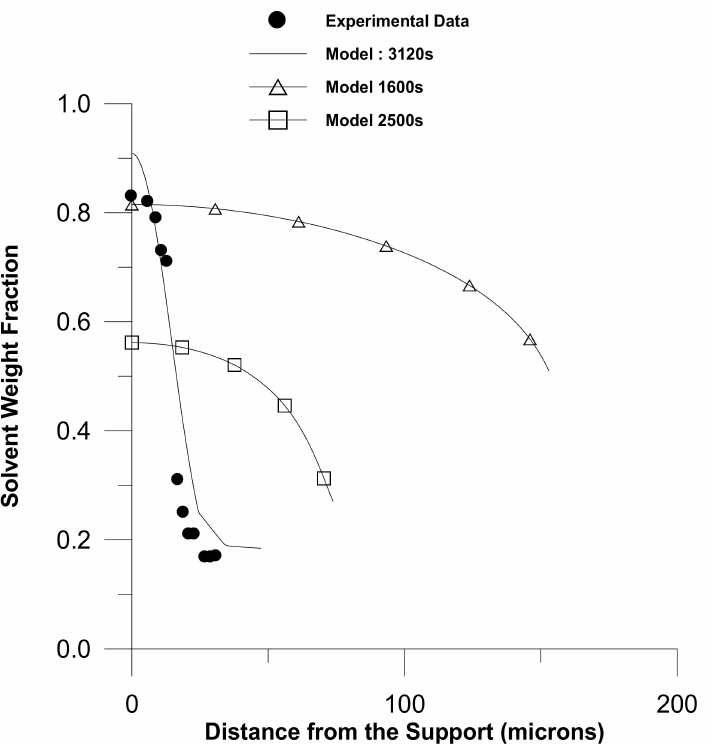
Figure 4. Non-Fickian diffusion for the system poly(methyl methacrylate)/ethyl benzene. Ethyl benzene weight fraction profiles. Initial ethyl benzene weight fraction: 0.9014, drying air = 298 K, initial coating thickness = 0.426 mm (used with copyright permission)